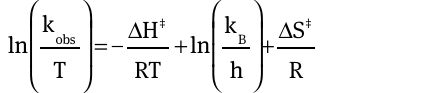
Figure 12: (a) The curve fittings of ln [SO] as a function of time (min) over the temperature range (90-120)°C; (b) Determination of activation energy from Arrhenius plot (ln k vs. 1/T) (reaction conditions: SO 4.5 M in PC, 6.5 mM ZnBr obs